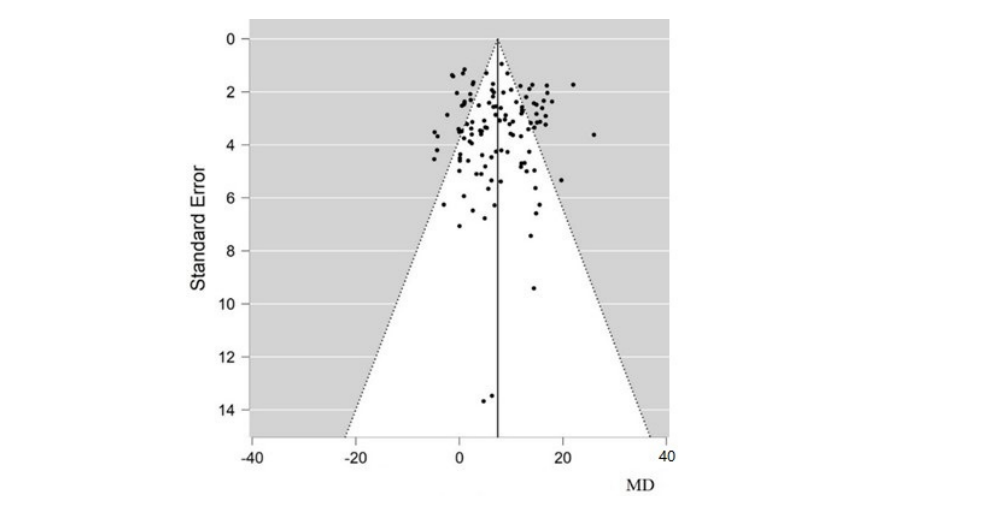
Figure 5. Funnel plot for LVEF improvement showing the absence of publication biases. The vertical solid line represents the estimated overall mean difference; black dots are the standard error of each study. MD, mean difference.